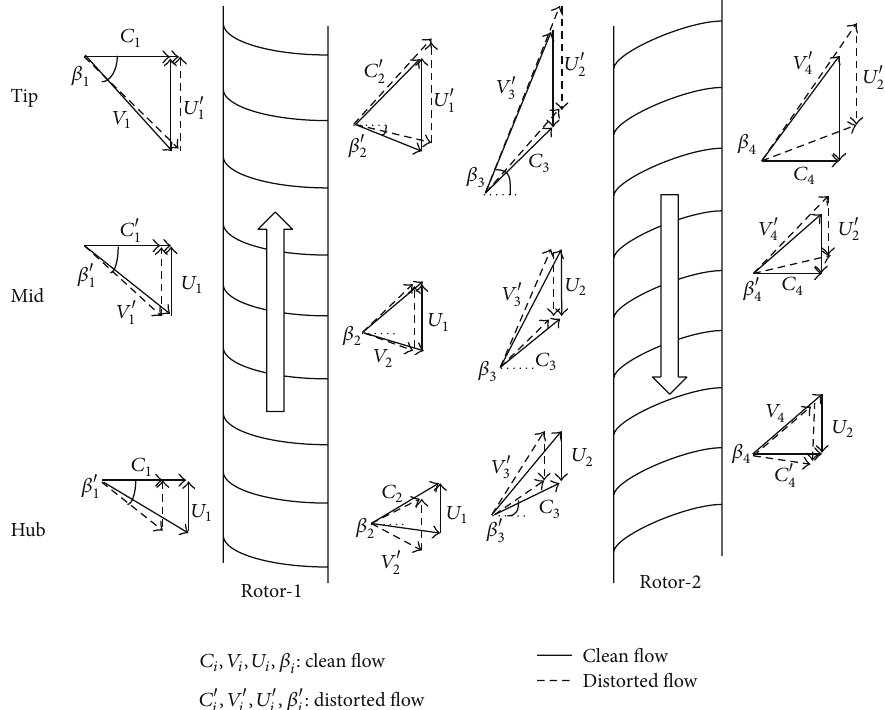
Figure 17: Velocity triangles along the span under hub-strong radial distortion operation.